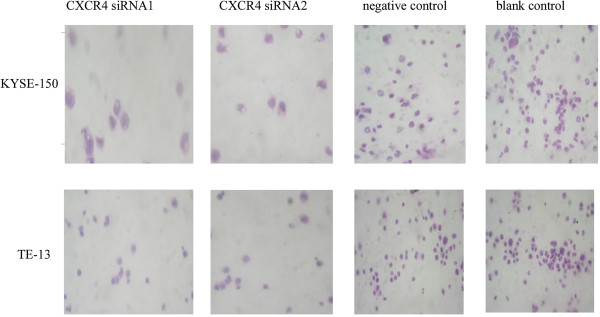
siRNA CXCR4 reduced esophageal carcinoma cells invasion in vitro. Cells were incubated with different synthetic oligonucleotides as described in the materials and methods section, and cells invasion ability was deteced by transwell invasion assay. The targeted CXCR4 siRNA reduced esophageal carcinoma cells invasion ability (*p <0.05).